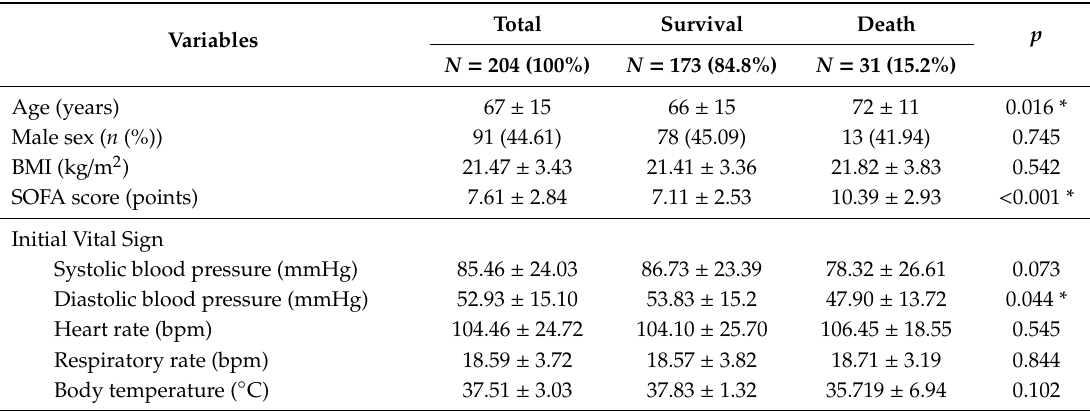
Figure 1. Flow diagram of patient inclusion. Table 1. Clinical characteristics of patients stratified by 30-day mortality.